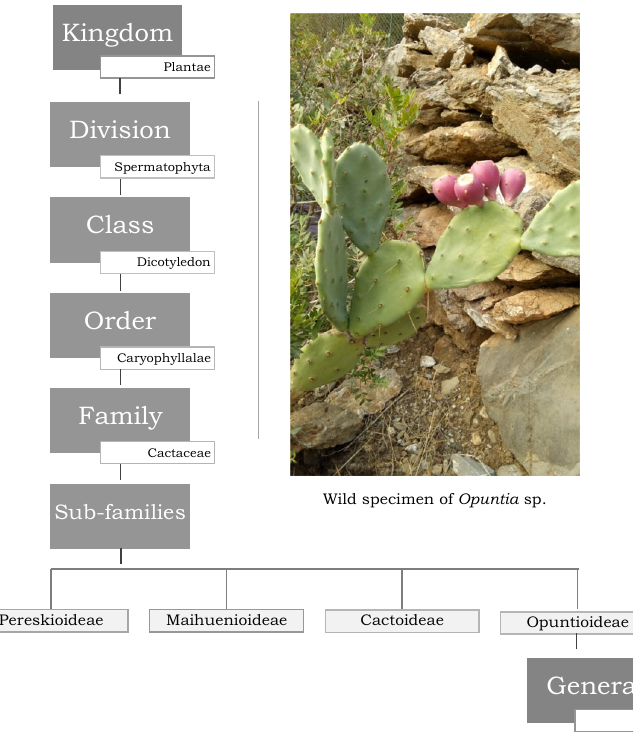
Figure 1. Taxonomic classification of Opuntia species (photograph from the author (W.Z.): wild Opuntia sp., Bejaia, Algeria).